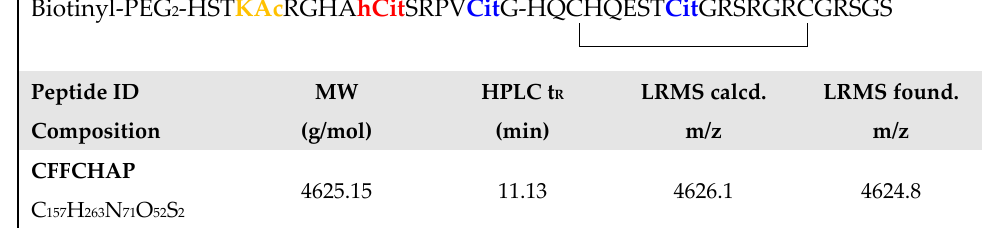
Figure 3. Primary sequence of chimeric fibrin/filaggrin citrullinated/homocitrullinated/acetylated peptide (CFFCHAP). Peptide identification (ID), elemental composition, molecular weight (MW), chromatographic retention time (t R ) by HPLC and mass calculated and found by low-resolution mass spectrometry (LRMS) were obtained by ESI-MS.